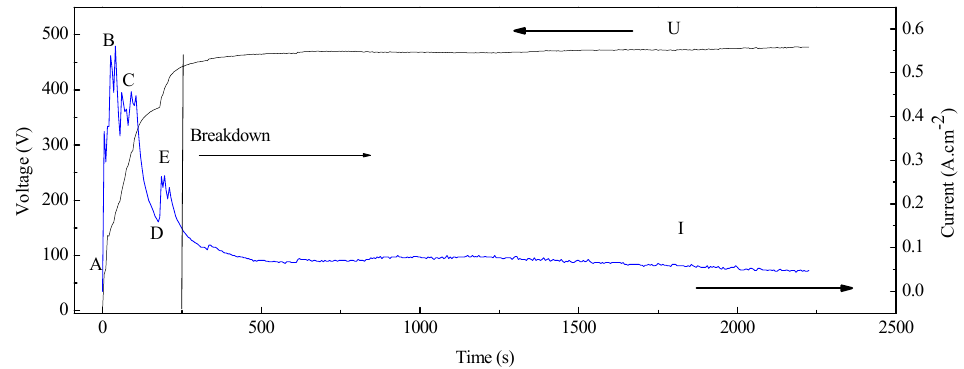
Figure 1. The discharge characteristics of K 2 ZrF 6 electrolyte during the PEO process.